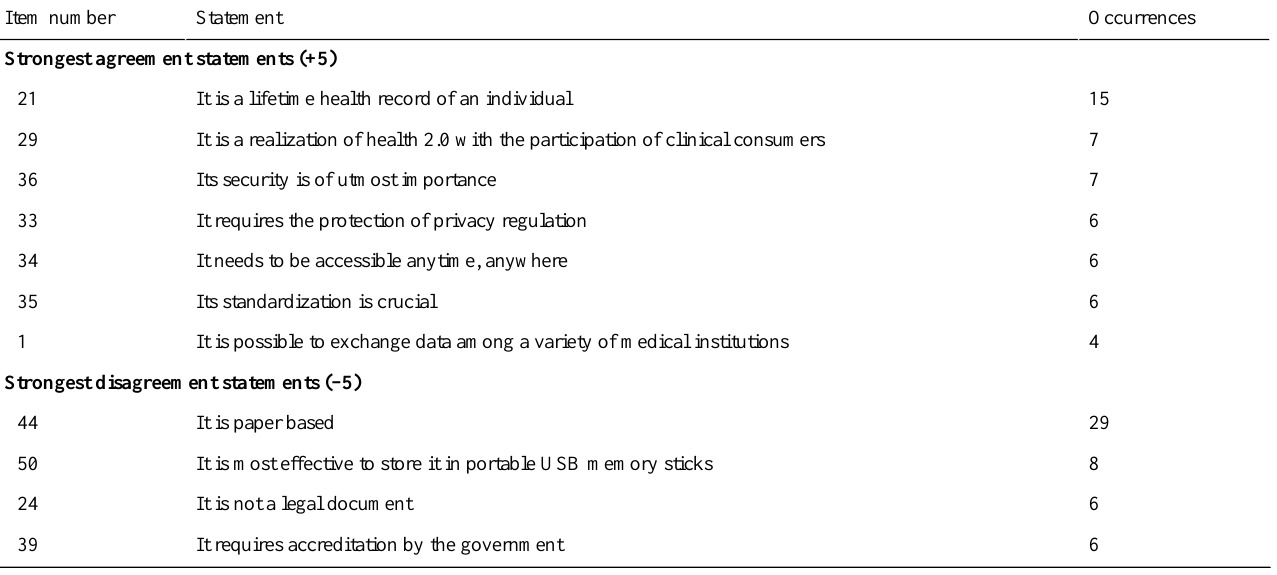
Table 2. Personal health record statements with the strongest agreement and